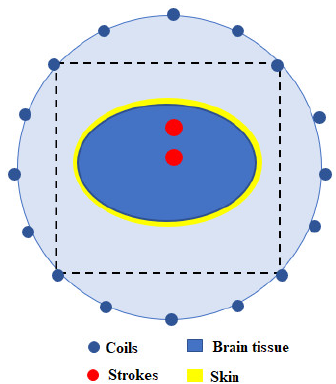
Figure 3. Head model and receiver array configuration.